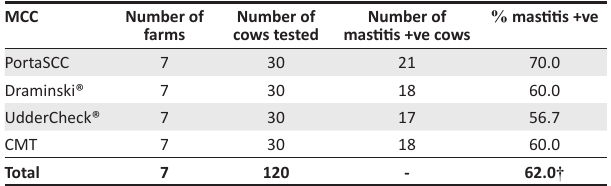
TABLE 1: Mastitis prevalence using different tests.